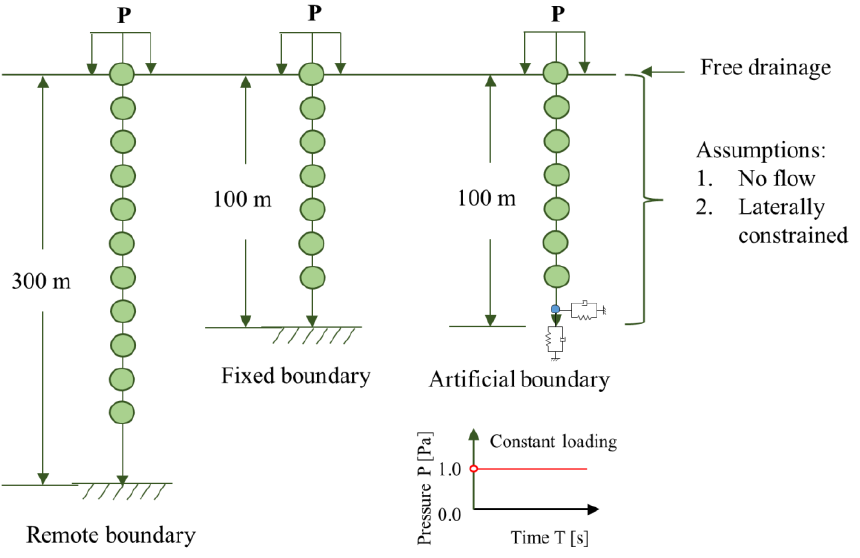
Figure 2. One-dimensional model of fluid-saturated porous media.